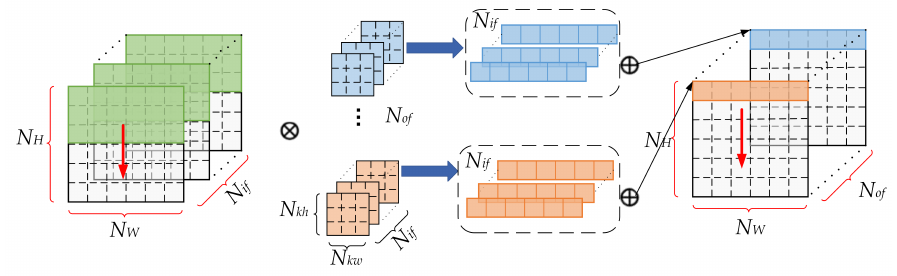
Figure 6. Computational dataflow of the rearranged convolution